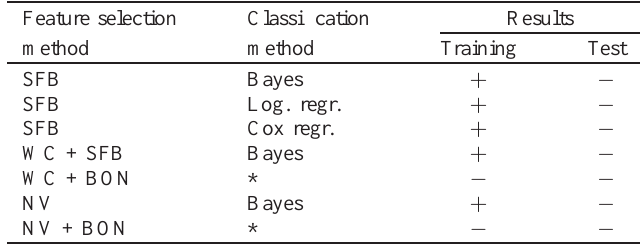
Table 1 Classification results for the different feature selection and